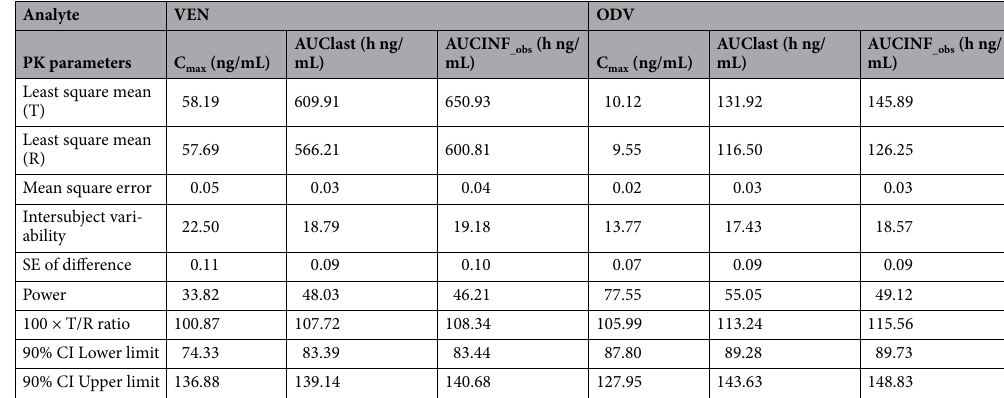
Table 12. Summary of statistical assurance of bioequivalent similarity of reference and test product.